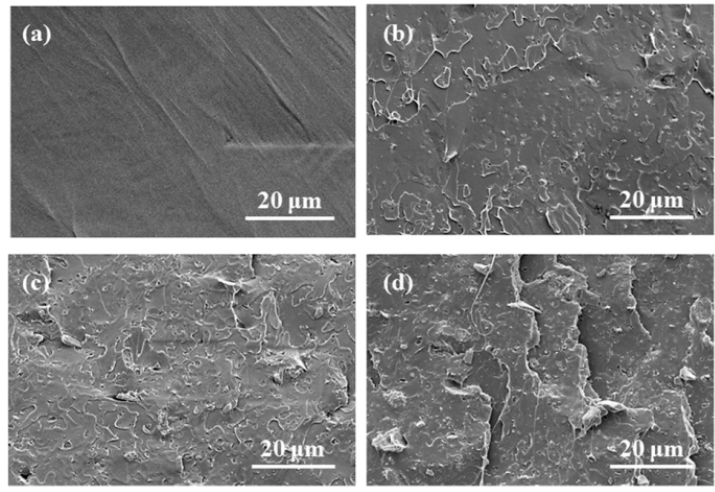
Figure 2. ( a ) XPS survey spectra, ( b ) C1s, ( c ) N1s, ( d ) P 2p and Co 2p of Co/P-C 3 N 4.